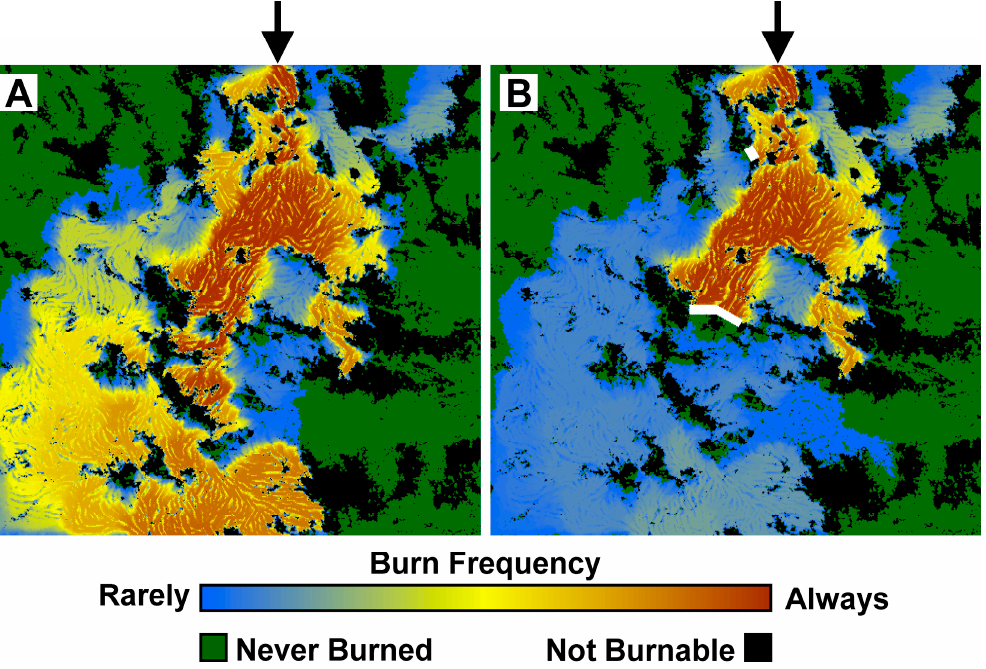
Figure 6. Mean burn frequencies ( A ) without and ( B ) including fuel breaks. Fuel breaks, shown in white, indicate areas where the fuel flammability was set to zero. Black arrows show the location at which the fires were initiated. These results were assembled from 100 replicate simulations.